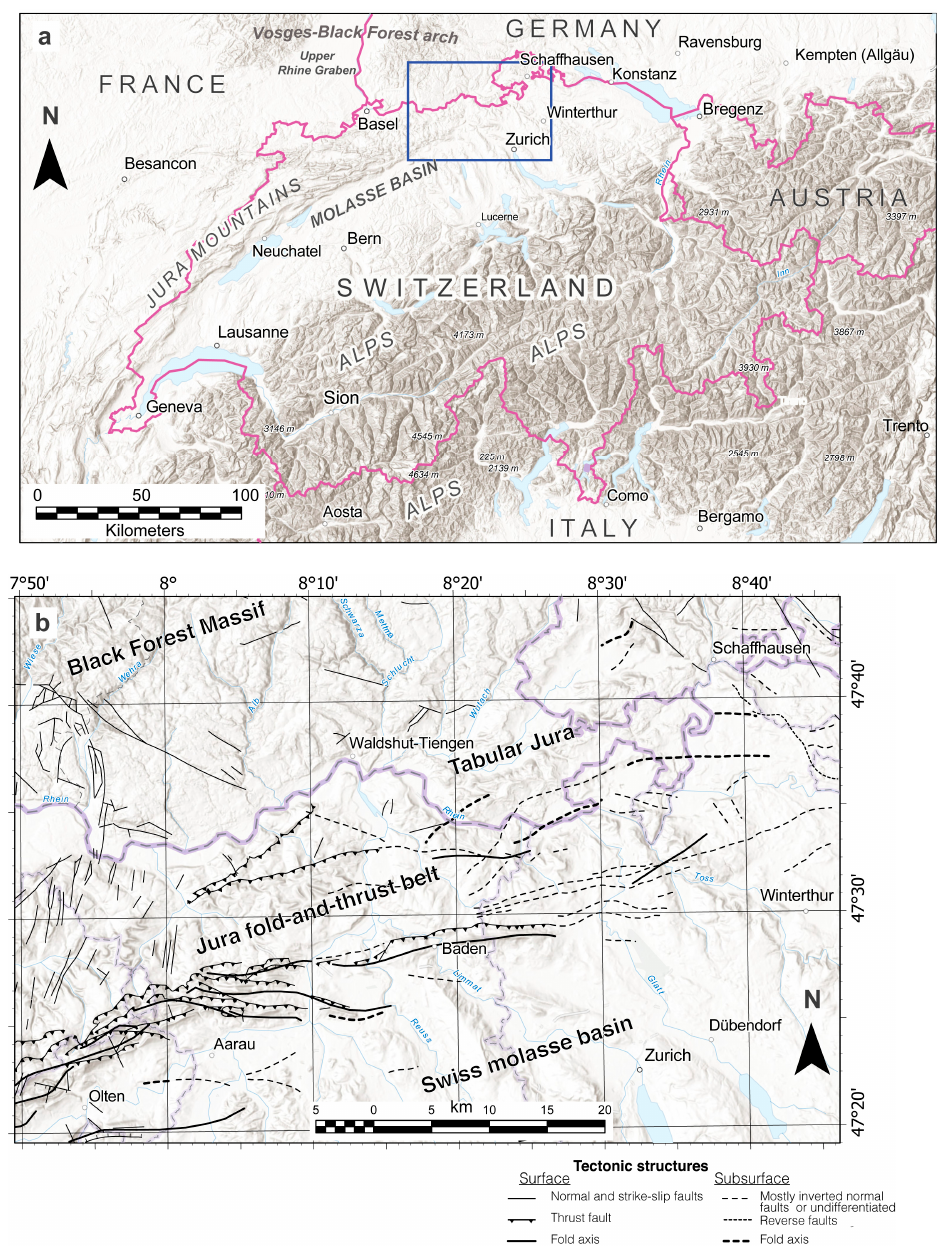
Figure 1. ( A ) Regional map of Switzerland showing the studied area (in blue). Shaded relief from ArcGIS Pro user community. ( B ) Tectonic map of the studied region modified from [1] showing the different morphotectonic units that are discussed in the text. The map includes also subsurface data reported by [4].